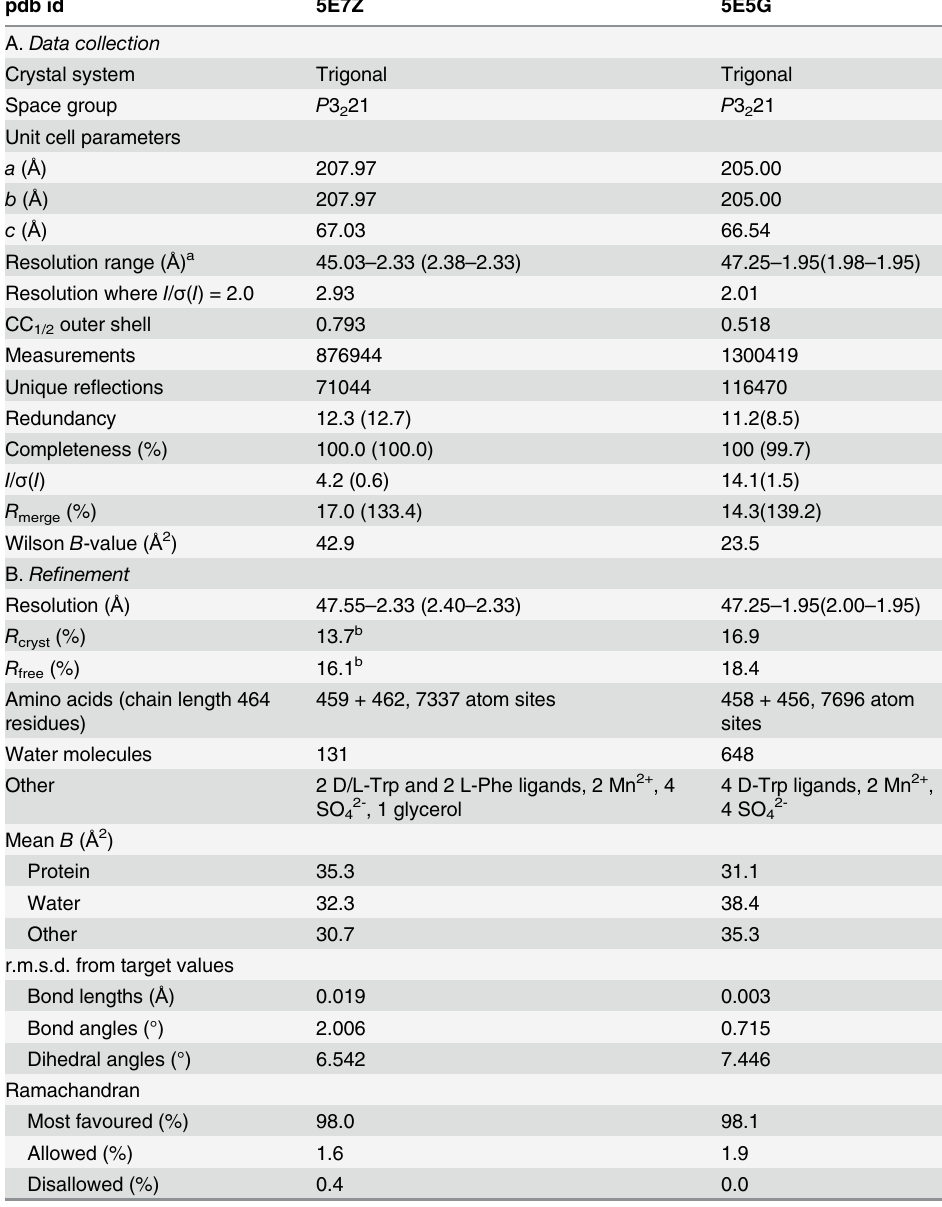
Table 4. Data collection and refinement statistics for structures reported in this publication (see also Table